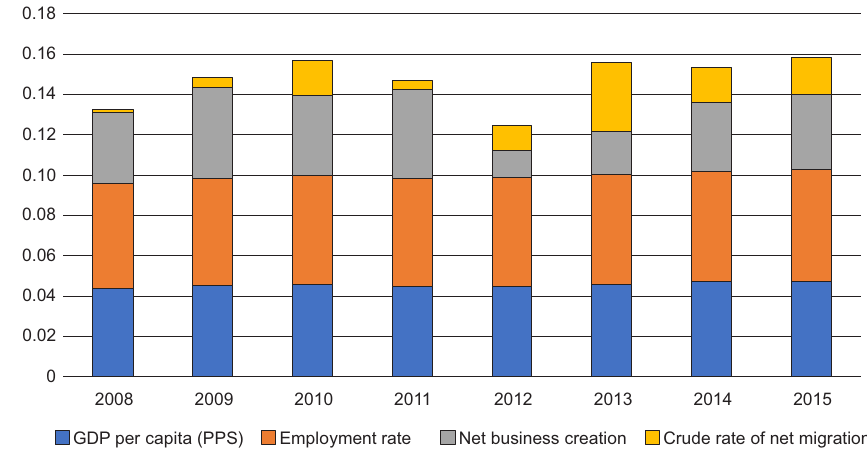
Fig. 4. Raw breakdown for the indicators of SSRR index for Osttirol, 2008 to 2015. Source: own calculations using data from Eurostat.